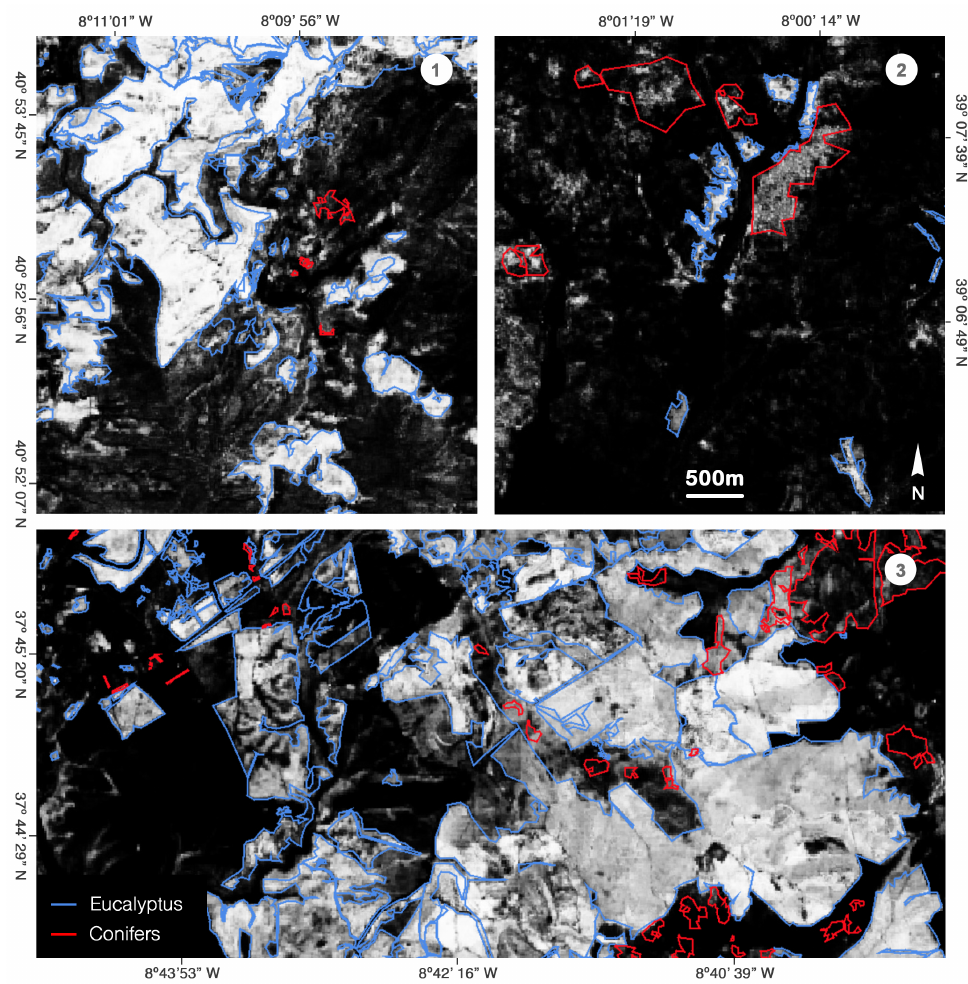
Figure 6. Plots of Eucalyptus (blue outlines) and coniferous (red outlines) forests in the three study areas (1–3). The predicted mean probability of a pixel being covered with Eucalyptus trees is shown in the range from 0 (black) to 1 (white) for the year